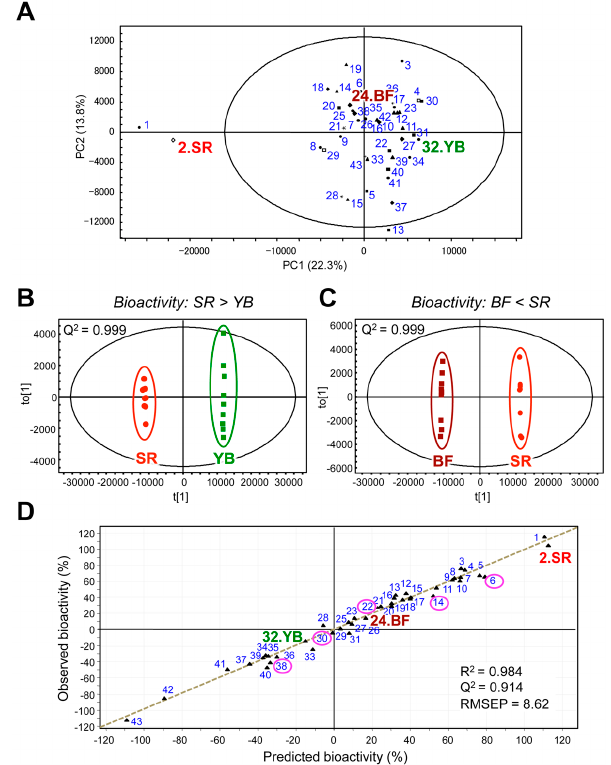
Figure 5. Multivariate statistical analyses of metabolic profiles of diverse green tea cultivars and their bioactivities. ( A ) PCA score plot shows separate clustering of metabolic profiles corresponding to Nou-6 and SR, and other cultivars. The number in the figure indicates the bioactivity ranking of the tea cultivar; OPLS-DA score plots ( B , C ) discriminate between the more bioactive SR cultivar and other cultivars, such as the non-bioactive Yabukita (YB) cultivar and the less bioactive Benifuuki (BF) cultivar. The predictive ability parameter Q 2 was 0.999, indicating that the OPLS-DA models were reliable; ( D ) The bioactivity-prediction PLS regression model was calculated from 43 tea samples included in 38 training and 5 test (pink circle) sets. The correlation coefficient R 2 and the cross-validated correlation coefficient Q 2 were both more than 0.9. The validation error, value root mean squared error of prediction (RMSEP), was less than 5% (8.62 = 3.8%). These results indicated that the PLS regression model was reliable. Adapted with permission from reference [8].